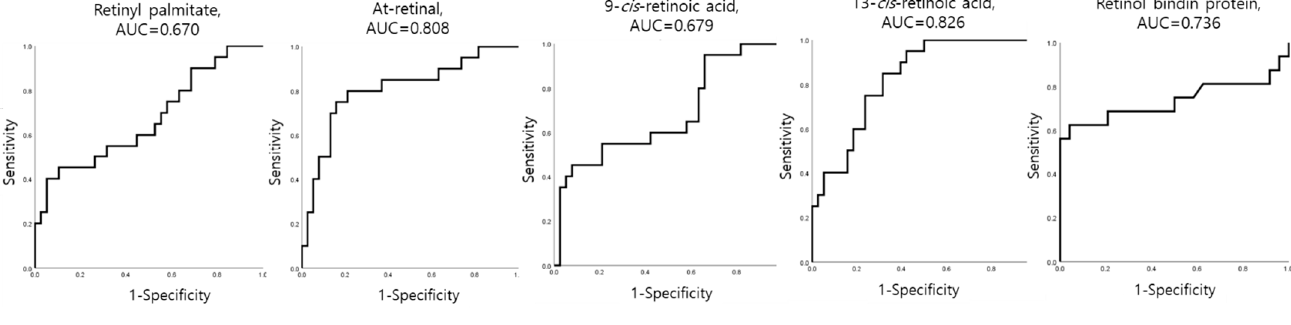
Figure 5. Receiver operating characteristics (ROC) curve analysis for metabolites: Predictive performance of signatures for preterm birth using ROC curves of sensitivity and specificity.